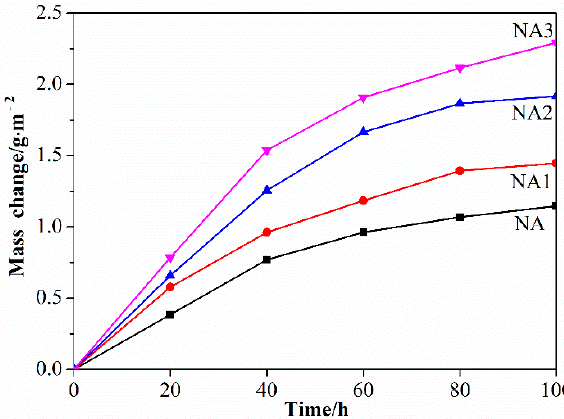
Figure 4. Oxidation kinetics curve of all composites.